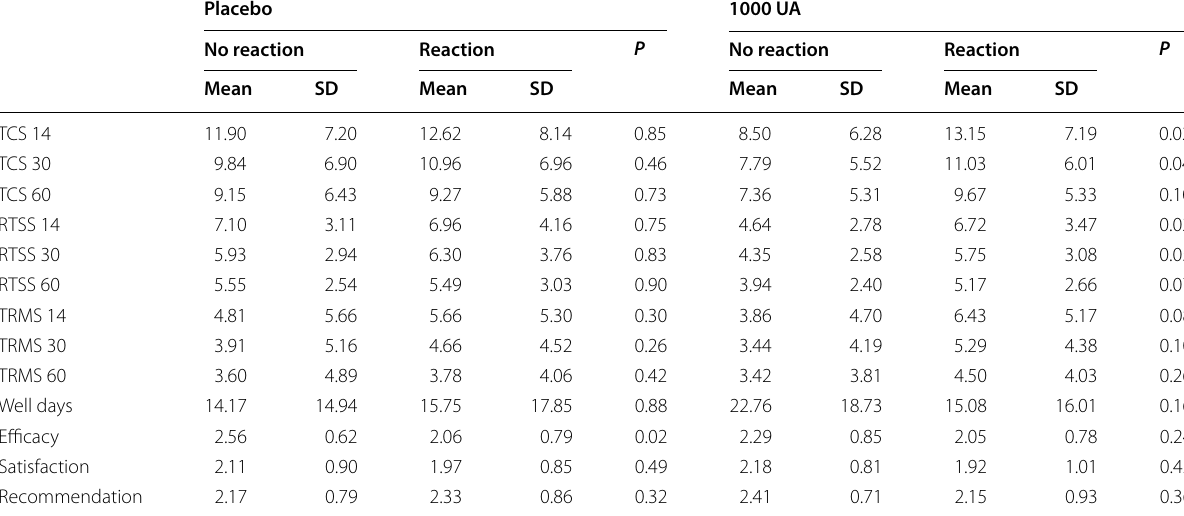
Table 5 Results of the tree pollen study